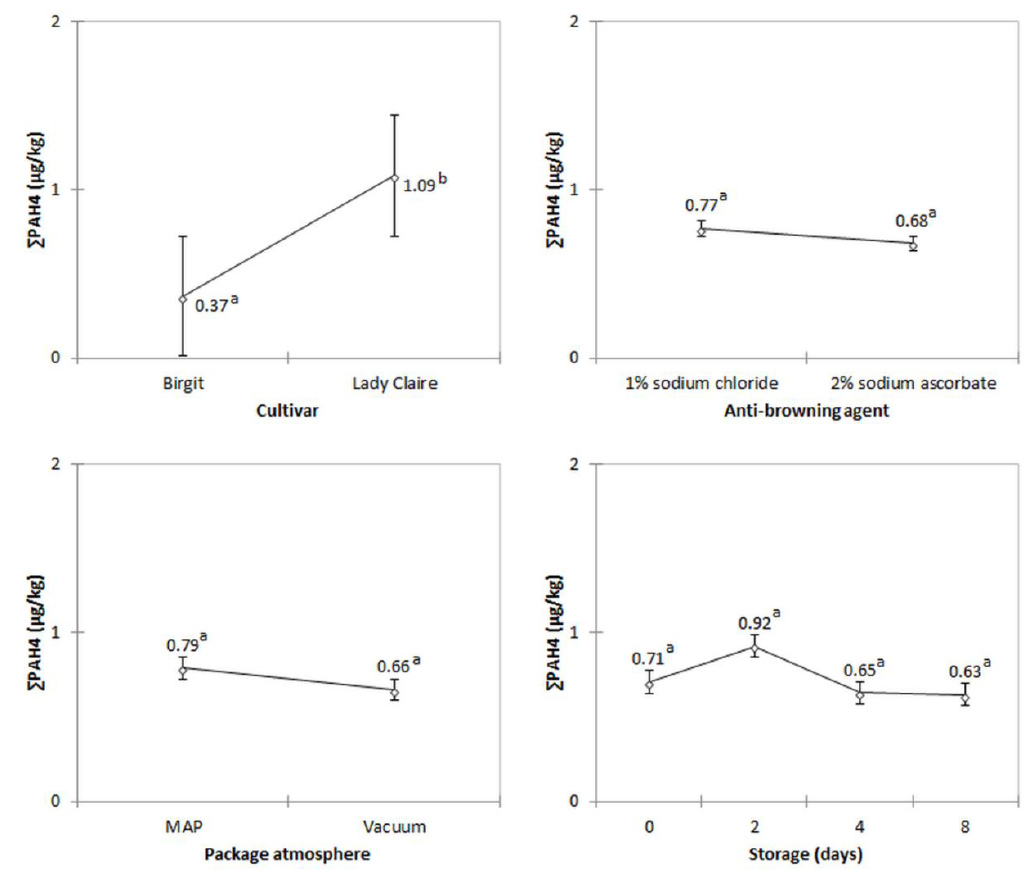
Figure 2. ΣPAH4 in fried fresh-cut potato as affected by the cultivar, anti-browning agent, packaging and storage duration. Results are expressed as mean ± SE of n = 16 for cultivars, anti-browning agents, package atmospheres and n = 8 for days. Values with different letters are statistically different at p ≤ 0.05.